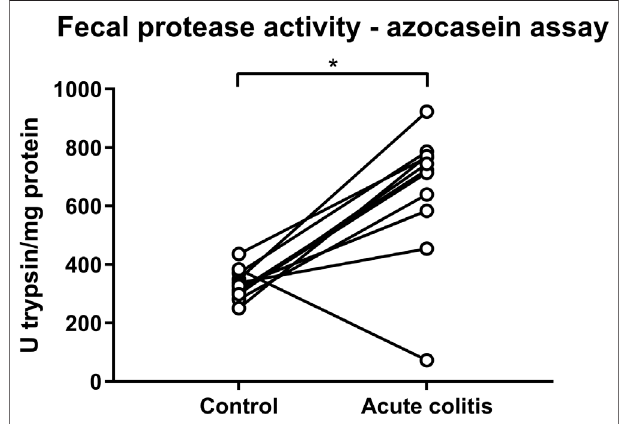
FIGURE 6 | Fecal protease activity in control vs. acute colitis rats as measuredwiththeazocasein assay.Theproteaseactivityexpressed asmean U trypsin/mg protein ± SEM in fecal samples of control and acute colitis animals. Wilcoxon signed rank test; n = 12; p < 0.05; signi fi cant effect of the factor “ group ”